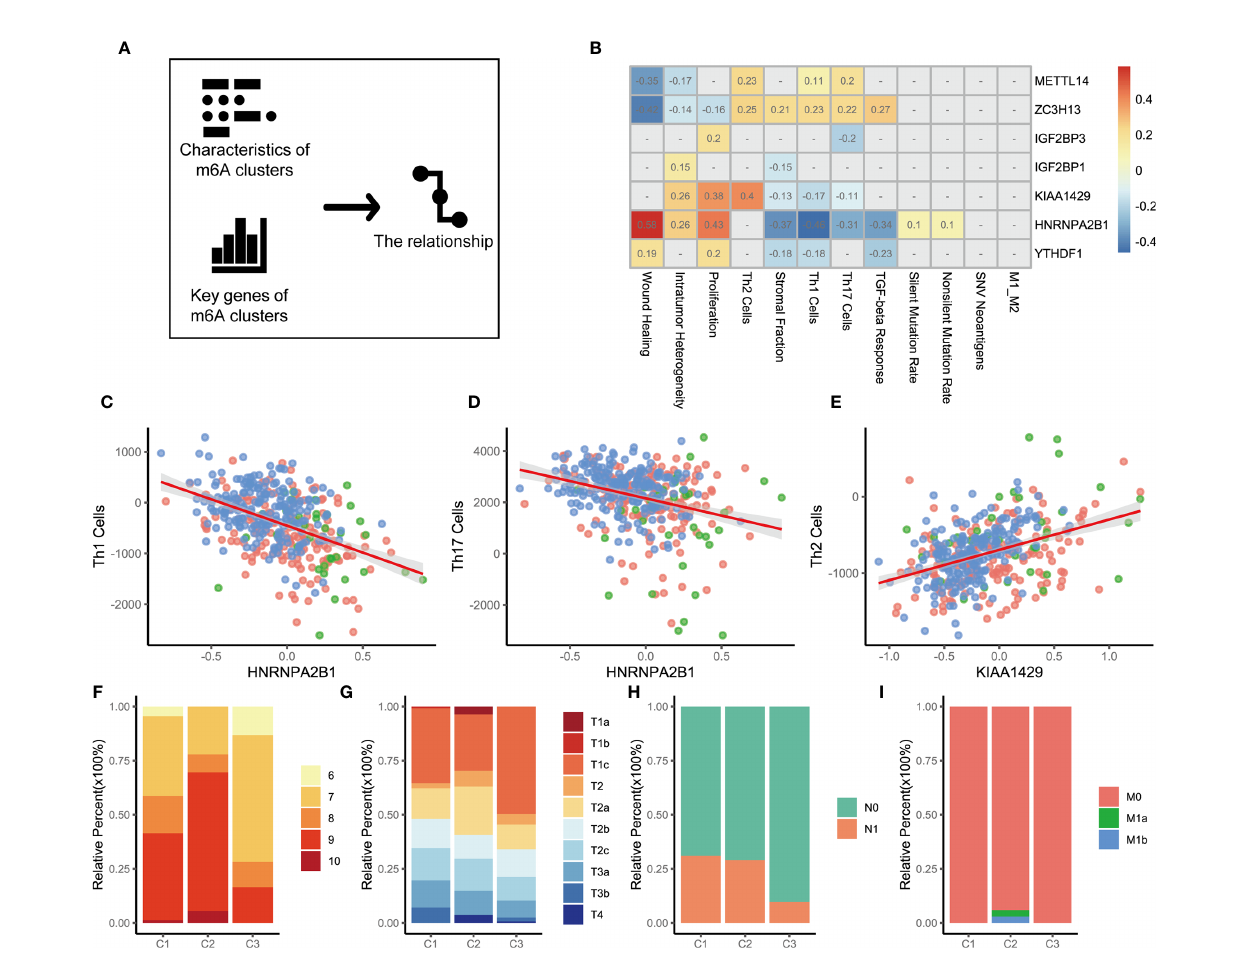
FIGURE 3 | The relationship between m6A genes and characteristics among three m6A regulators clusters. (A) The schematic diagram. (B) The heatmap shown that correlation between 7 m6A genes and characteristics of m6A regulators clusters. Positive correlation was marked with red. Negative correlation was marked with blue. The correlation coef fi cient was showed in square box. “ NA ” means p>0.05. (Spearman test). (C – E) . Scatter diagram were showed the correlation between Th1 cells and HNRNPA2B1, Th17 Cells and HNRNPA2B1, Th2 Cells and KIAA1429. (F) Differences in Gleason score among three m6A regulators clusters. (p=0.009). (G) Differences in distant metastasis among three m6A regulators clusters. (p=0.008) (H) Differences in regional lymph node metastasis among three m6A regulators clusters. (p<0.001) (I) Differences in primary tumor stage among three m6A regulators clusters.